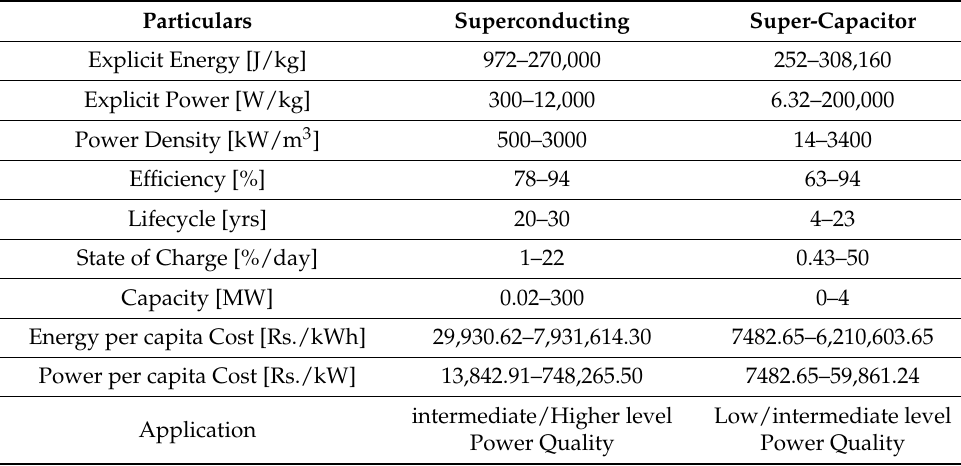
Table 4. Diverse SMES and super-capacitor storage devices